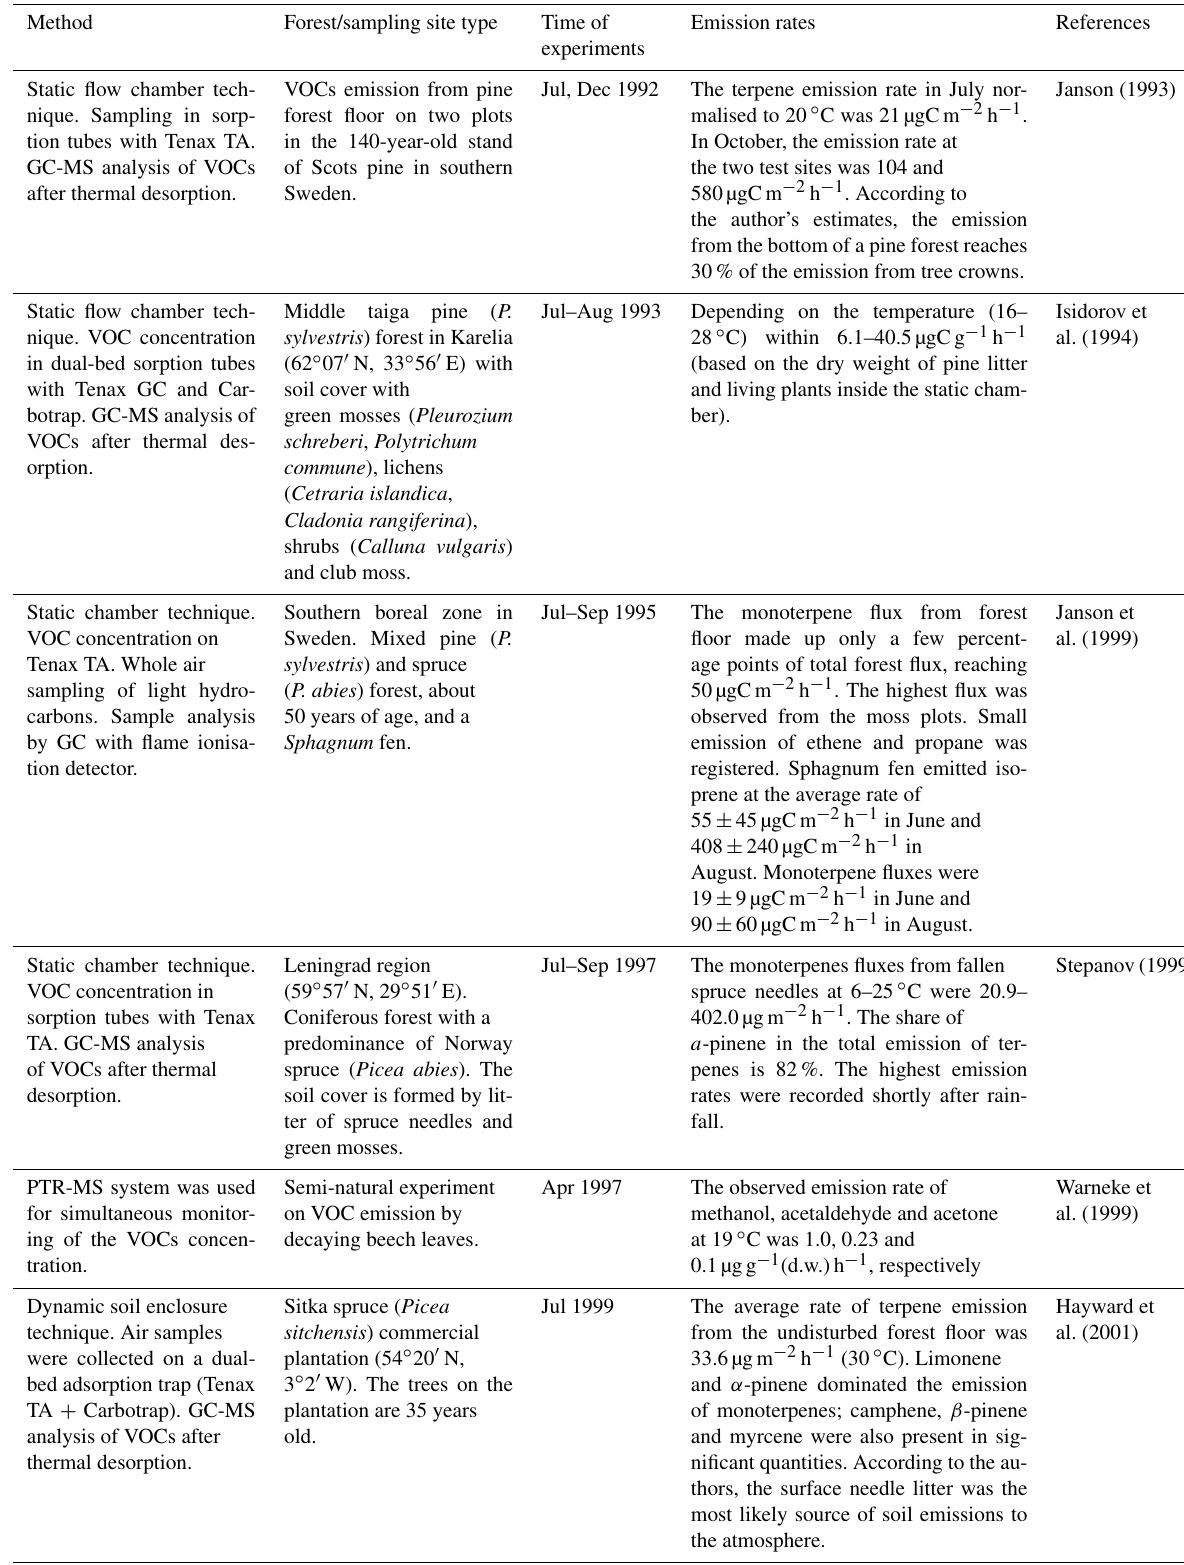
Table 5. Field measurements of VOC emissions from forest